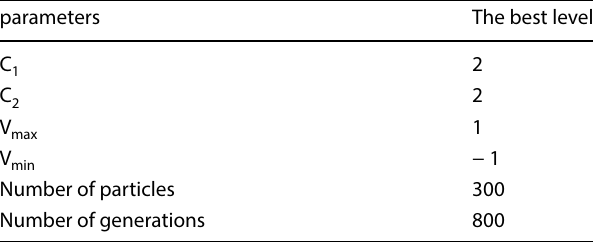
Table 6 Appropriate parameters of PSO